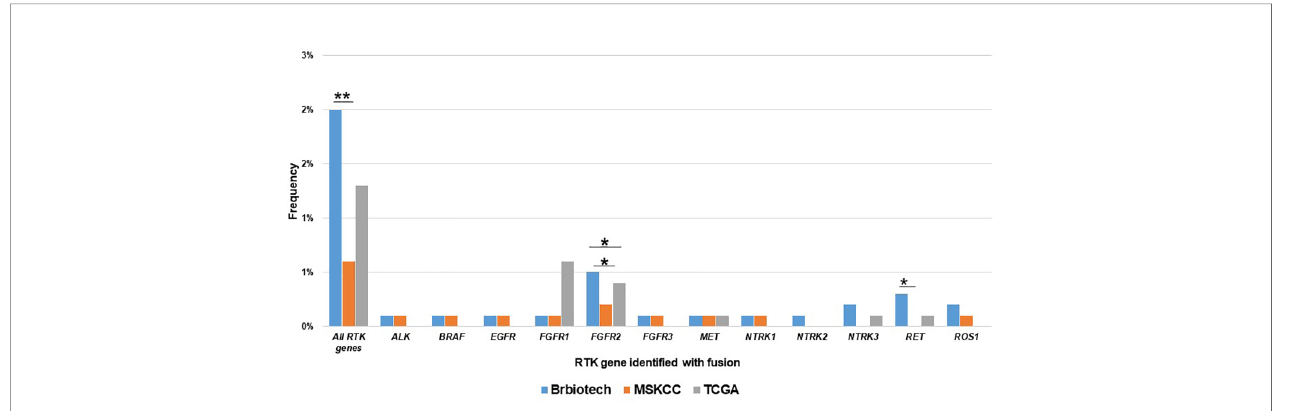
FIGURE 2 | Comparison of the prevalence RTK fusions among different databases. Brbiotech (n=1440), MSKCC (n=1756), TCGA (n=996) *P-value <0.05; **P-value